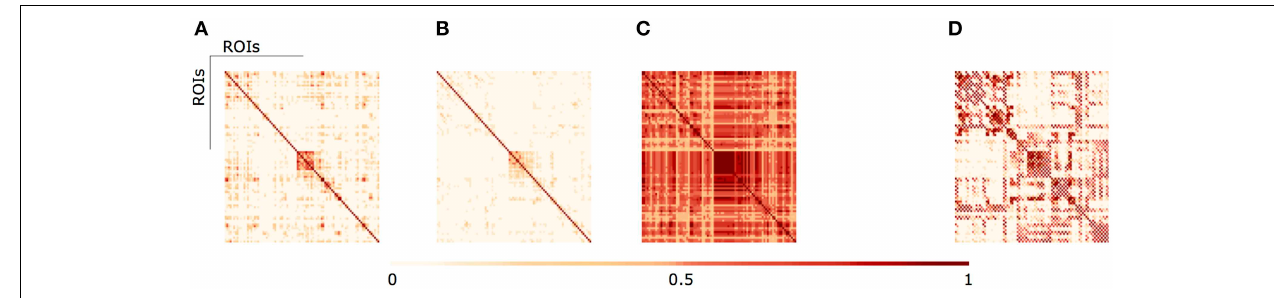
FIGURE 3 | (A) fMRI single subject network (B) Average aggregated fMRI network (C) fMRI Algebraic Topologically aggregated (multiplex) network (D) DTI network.